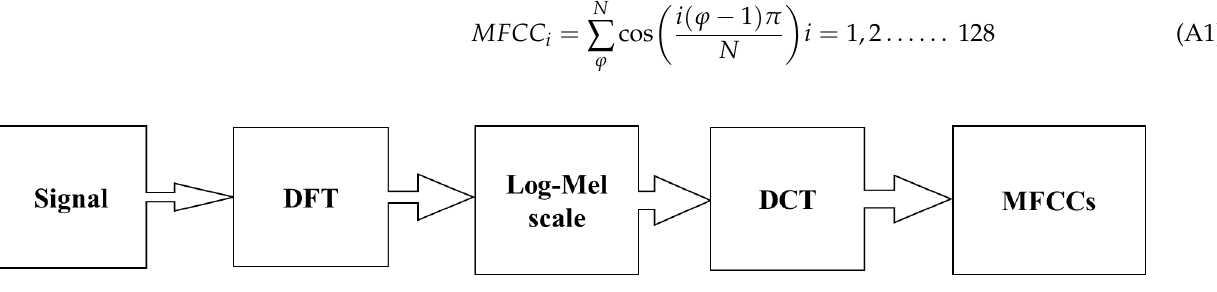
Figure A1. Steps of MFCC Process.